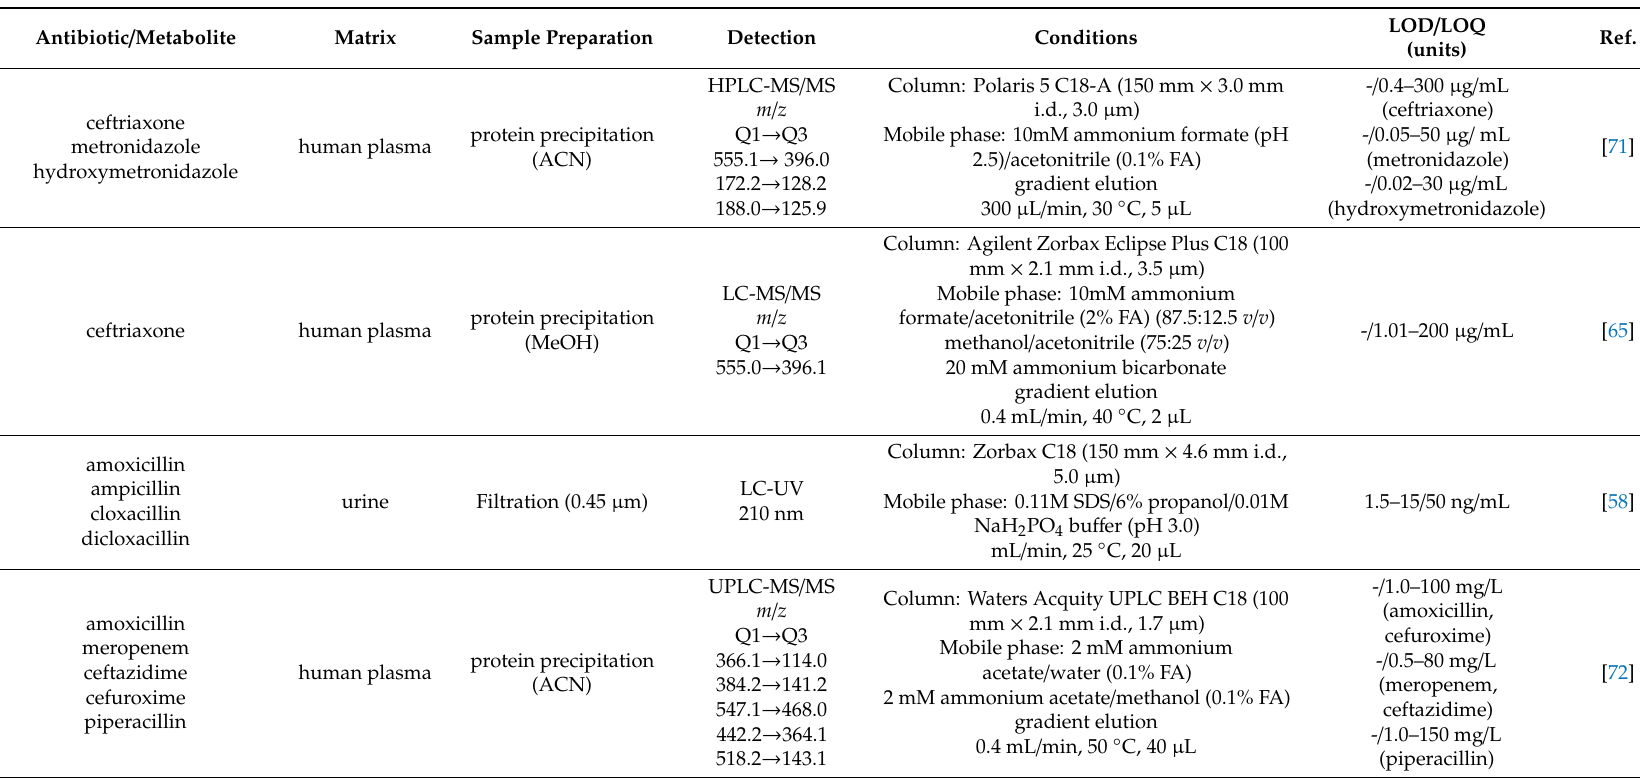
Table 2. Identification and determination of antibiotics and their metabolites by the liquid chromatography